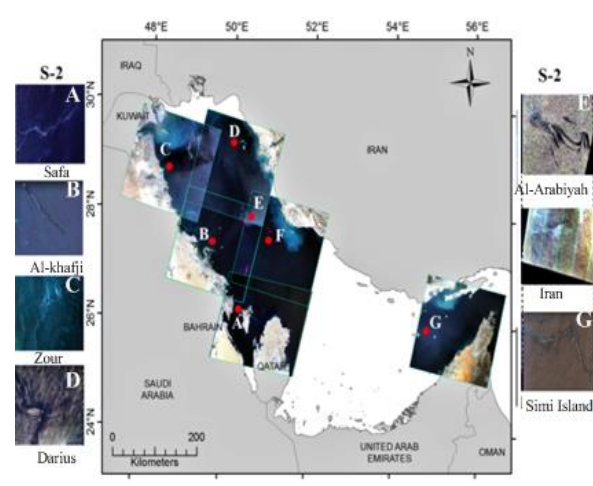
Figure 1. Study area – oil spills occurrences